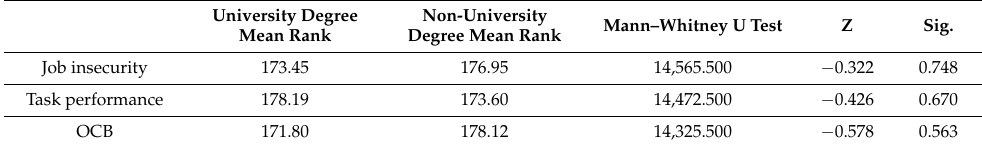
Table 5. Education differences in job insecurity, task performance and OCB (Mann–Whitney